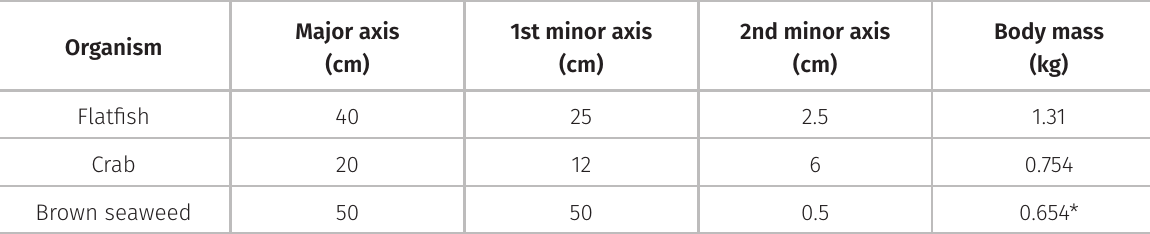
Table I. Dimensions of the ICRP (2008) reference